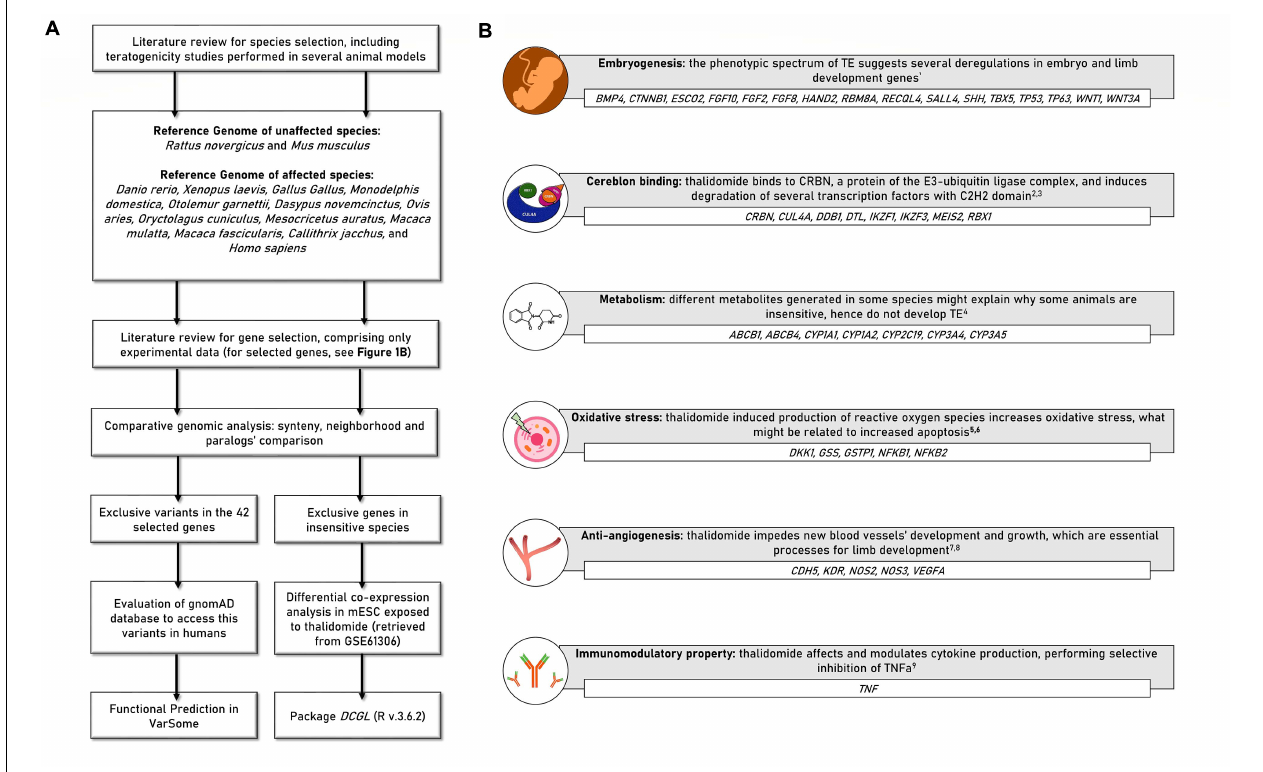
FIGURE 1 | (A) Scheme presenting the study delineation and analyses. (B) Forty-two candidate genes selected for the comparative analyses. BMP4 , Bone morphogenetic protein 4; CTNNB1 , Catenin beta-1; ESCO2 , Establishment of Sister Chromatid Cohesion N-Acetyltransferase 2; FGF10 , Fibroblast growth factor 10; FGF2 , Fibroblast Growth Factor 2; FGF8 , Fibroblast Growth Factor 8; HAND2 , Heart And Neural Crest Derivatives Expressed 2; RBM8A , RNA Binding Motif Protein 8A; RECQL4 , RecQ Like Helicase 4; SALL4 , Sal-like protein 4; SHH , Sonic Hedgehog Signaling Molecule; TBX5 , T-Box Transcription Factor 5; TP53 , Tumor Protein P53; TP63 , Tumor Protein P63; WNT1 , Wnt Family Member 1; WNT3A, Wnt Family Member 3A; CRBN , Cereblon; CUL4A , Cullin 4A; DDB1 , Damage Specific DNA Binding Protein 1; DTL , Denticleless E3 Ubiquitin Protein Ligase Homolog; IKZF1 , IKAROS Family Zinc Finger 1; IKZF3 , IKAROS Family Zinc Finger 3; MEIS2, Meis Homeobox 2; RBX1, Ring-Box 1; ABCB1 , ATP Binding Cassette Subfamily B Member 1; ABCB4 , ATP Binding Cassette Subfamily B Member 4; CYP1A1 , Cytochrome P450 1A1; CYP1A2 , Cytochrome P450 1A2; CYP2C19 , Cytochrome P450 2C19; CYP3A4 , Cytochrome P450 3A4; CYP3A5 , Cytochrome P450 3A5; CDH5 , Cadherin 5; KDR , Kinase Insert Domain Receptor; NOS2 , Nitric oxide synthase 2; NOS3 , Nitric Oxide Synthase 3; VEGFA , Vascular endothelial growth factor A; DKK1 , Dickkopf WNT Signaling Pathway Inhibitor 1; GSS , Glutathione synthetase; GSTP1 , Glutathione S-transferase P; NFKB1, Nuclear